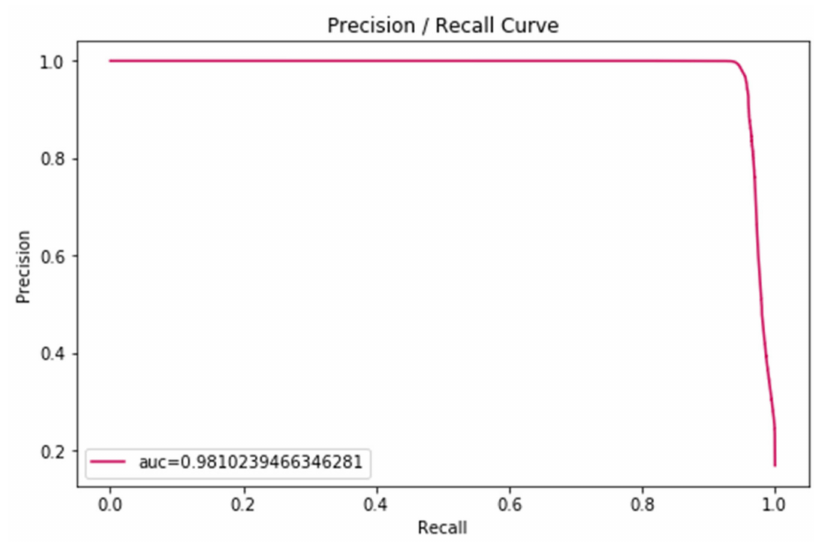
Figure 5. Precision-recall curve with average precision/recall score ≈ 98.10%.